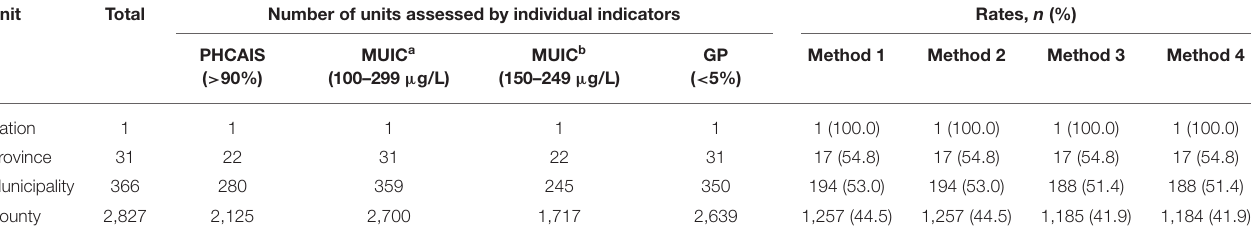
TABLE 2 | Evaluation results of IDD in China.